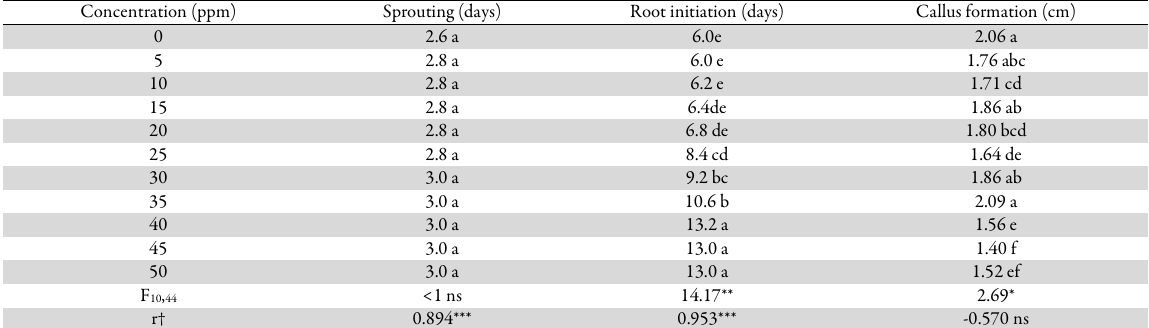
Table 1. Days for initiation of shoots, roots and callus formation in the stem of Talinum portulacifolium exposed to various concentrations of Zinc Concentration (ppm)